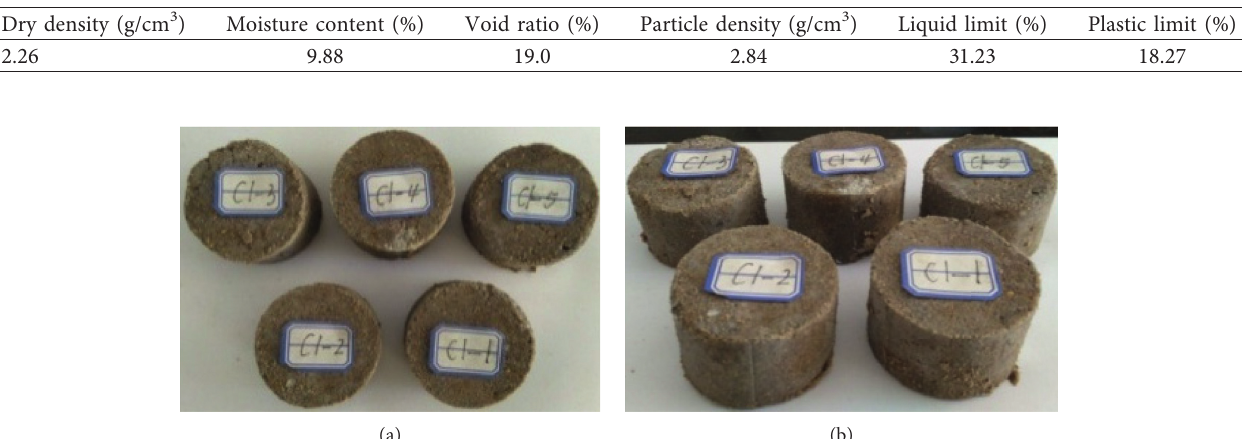
Table 1: Sand parameters.